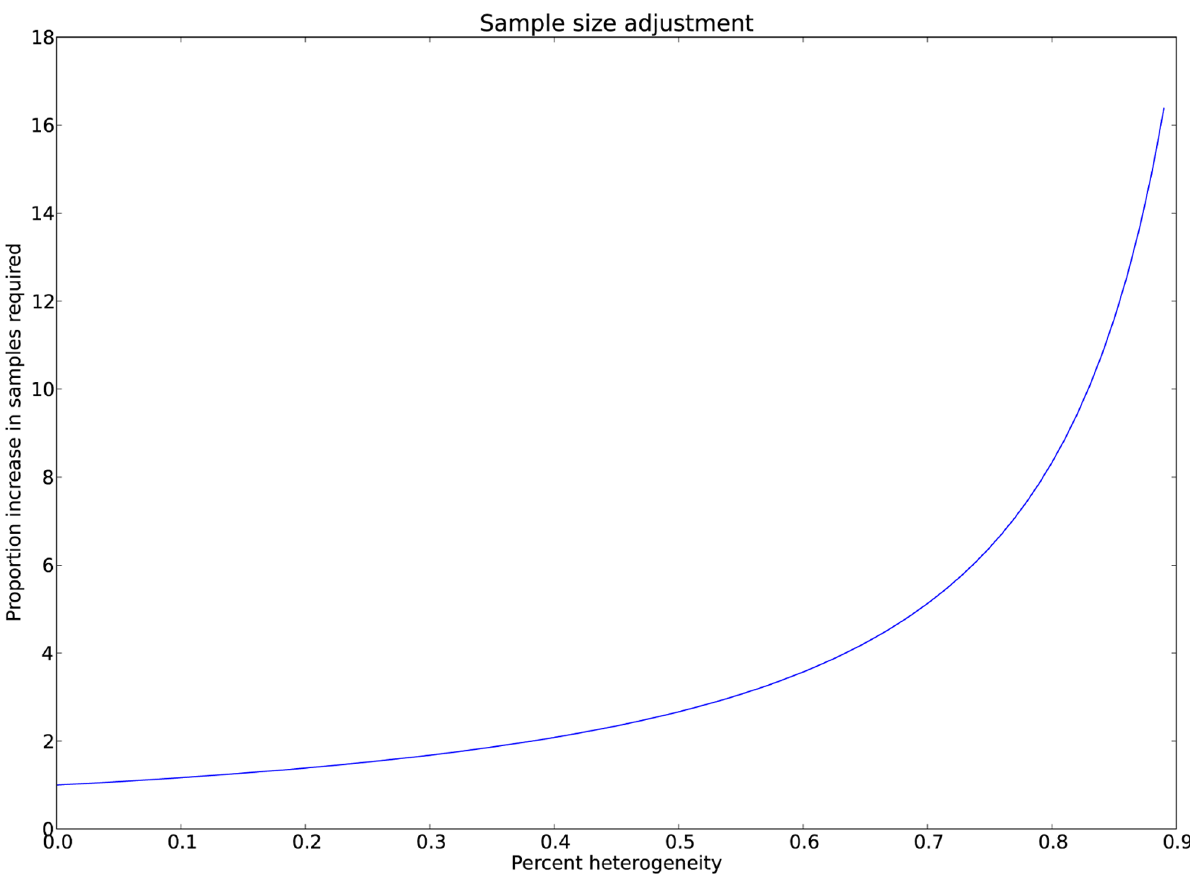
Figure 5. Sample size calculation due to heterogeneity. The increase in samples ( c ) required as heterogeneity, defined by s , increases for given values of a, b, c, d, when these values approach being equal. For example, if a=1000, b=2000, c=1200 and d=1800, and c is estimated as 40% of cases not in the subgroup on which a given SNP acts, a relative increase in samples of 2.1 is needed to attain similar association statistics in the entire cohort as that of the underlying subgroup.